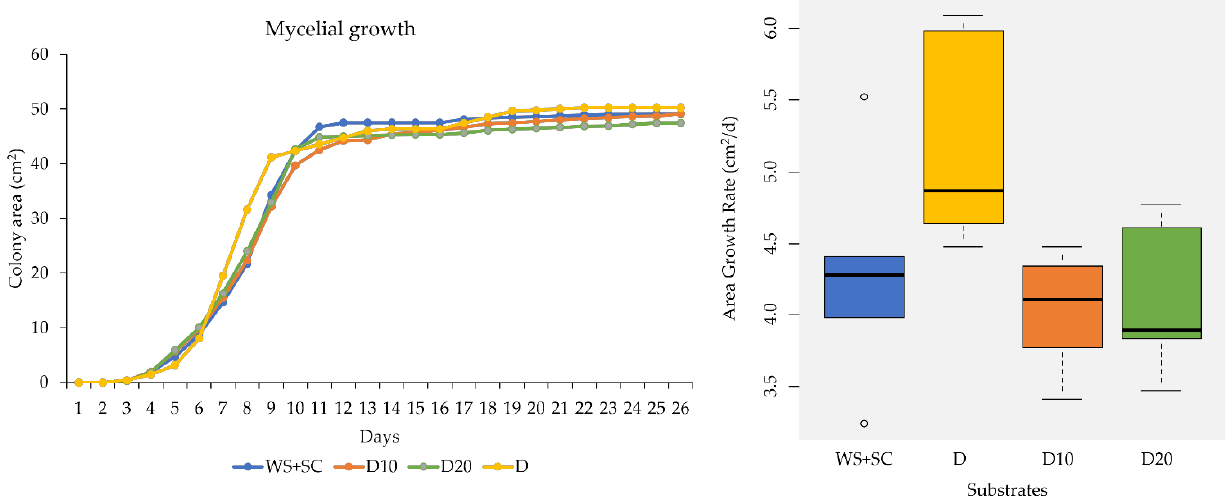
Figure 3. Mycelial growth and AGR of P. ostreatus in Petri dishes on WS + SC (blue), D10 (orange), D20 (green), and D (yellow). Statistical differences ( p < 0.05) between D-D10.